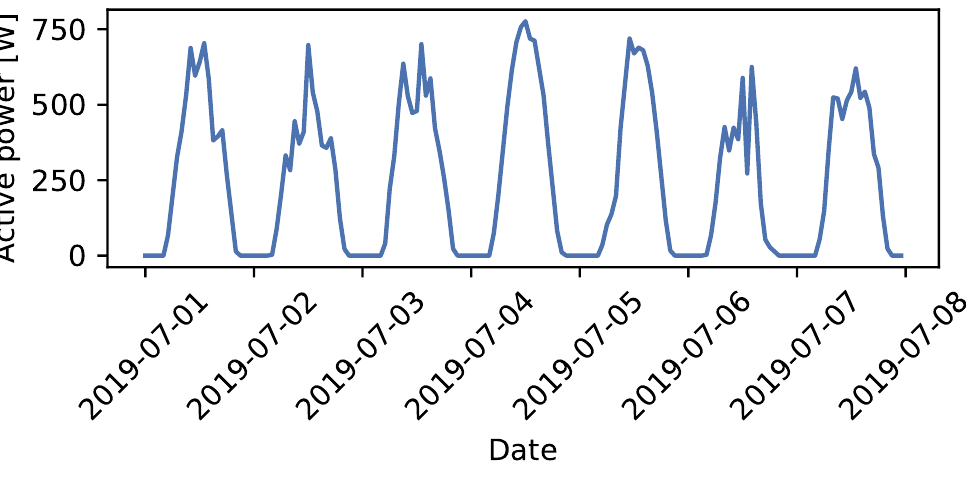
Figure 10. Example of the reference profile with which the baselining methods are